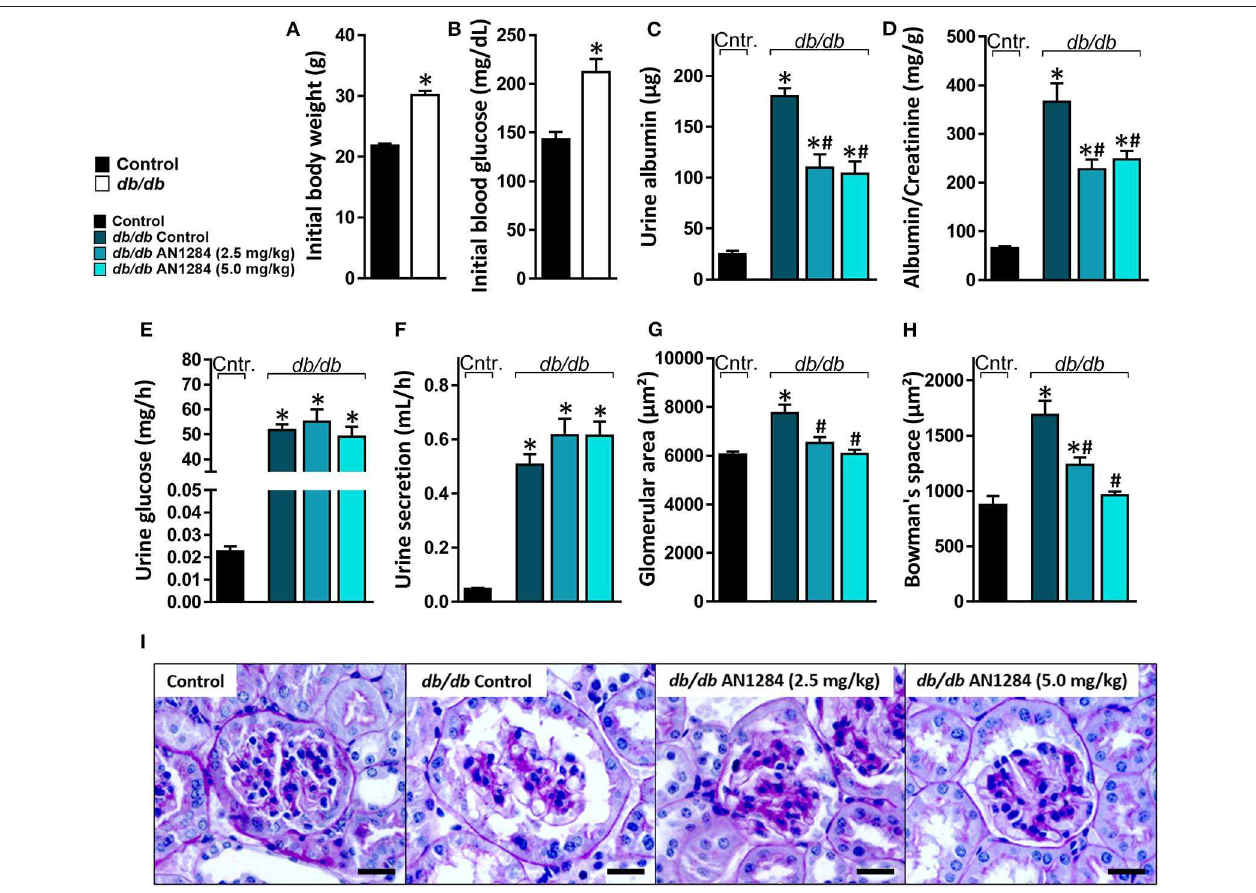
FIGURE 2 | AN1284 preserves kidney morphology and function in type 2 diabetic mice. Compared to the healthy controls, db/db mice exhibited increased body weight (A) and hyperglycemia (B) at the beginning of the experiment. AN1284 significantly reduced the elevated levels of urine albumin (C) and the albumin-to-creatinine ratio (D) , but not the urine glucose levels (E) and the urine secretion volume (F) . AN1284-treated db/db animals exhibited a reduction in the glomerular area (G,I) , and in Bowman’s space area (H,I) . Scale bar, 20 µ m. Data represent the mean ± SEM from 8 to 10 mice per group. * P < 0.05 relative to control non-diabetic mice, # P < 0.05 relative to db/db -Veh-treated control